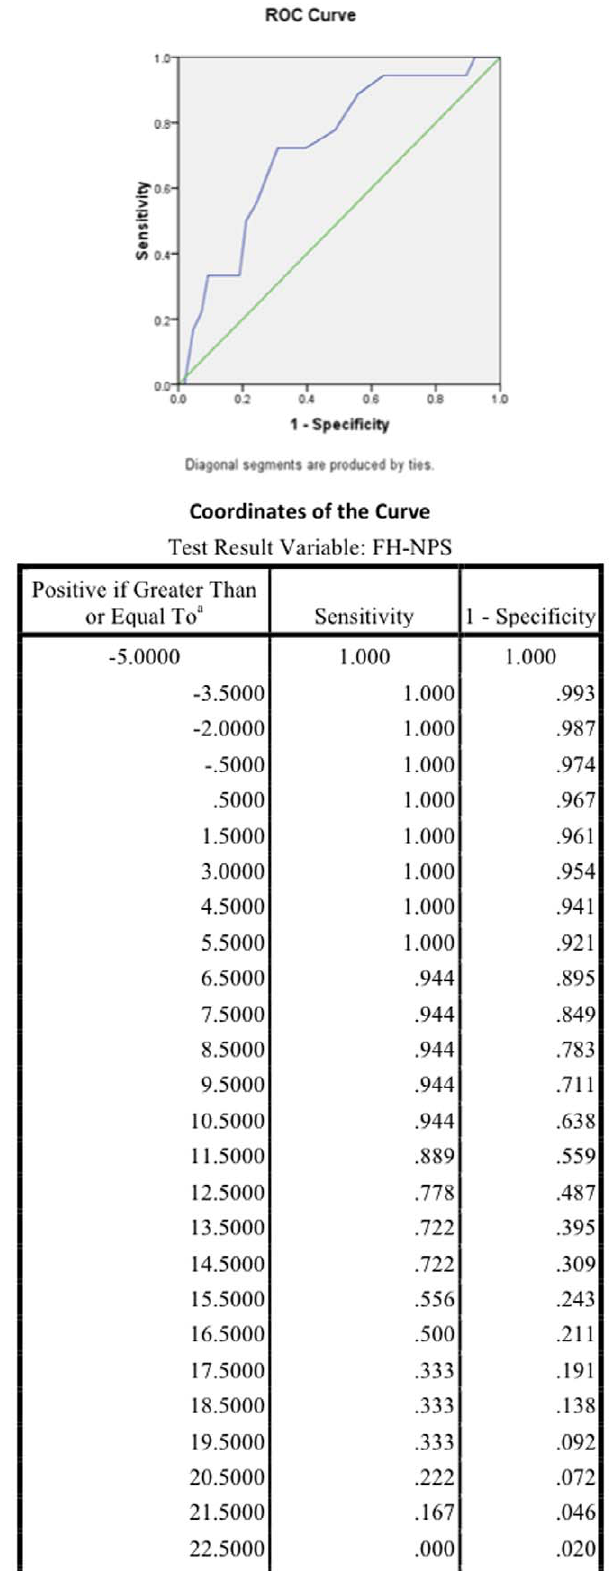
Figure 2. ROC curve for Frantic Hopelessness minus Near Psychotic Somatization (FH-NPS) as a predictor of substantive current suicide attempt. This post hoc analysis shows the Receiver Operator Characteristic curve and its coordinates for the FH-NPS score derived by subtracting scores on the ‘‘Near Psychotic Somatization’’ subscale of the STS-3 from scores on the ‘‘Frantic Hopelessness’’ subscale of the